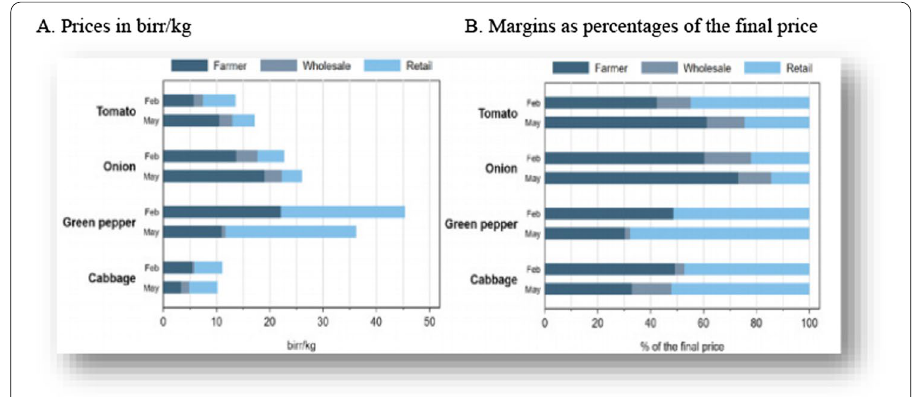
Fig. 1 Vegetable price structure before and during the pandemic, by vegetable type. Source: (IFPRI, 2020). A Prices in birr/kg. B Margins as percentages of the final